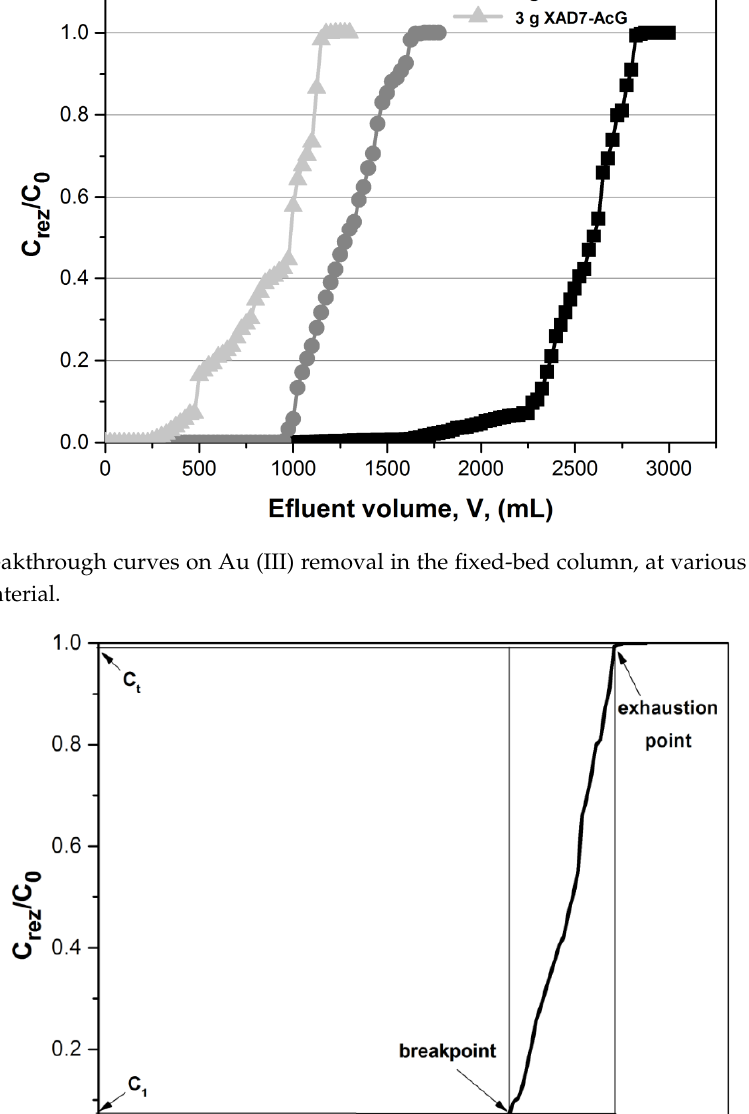
Figure 3. Breakthrough curves on Au (III) removal in the fixed-bed column, at various amounts of adsorbent material.